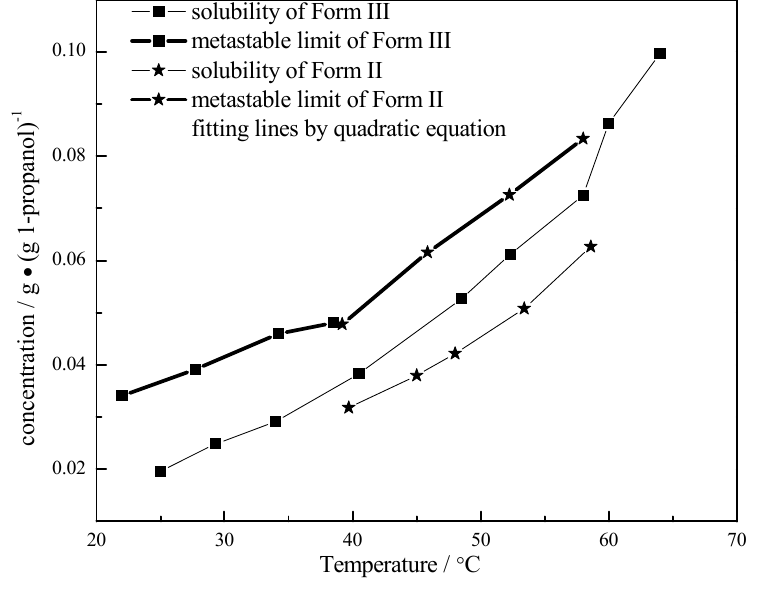
Figure 6. The metastable limits and fitting curves for Carbamazepine of Forms II and III.